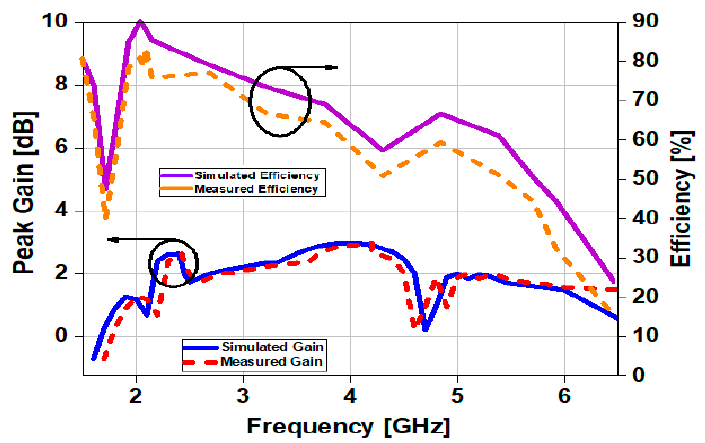
Figure 11. Shows Gain and efficiency of the proposed antenna have been measured and